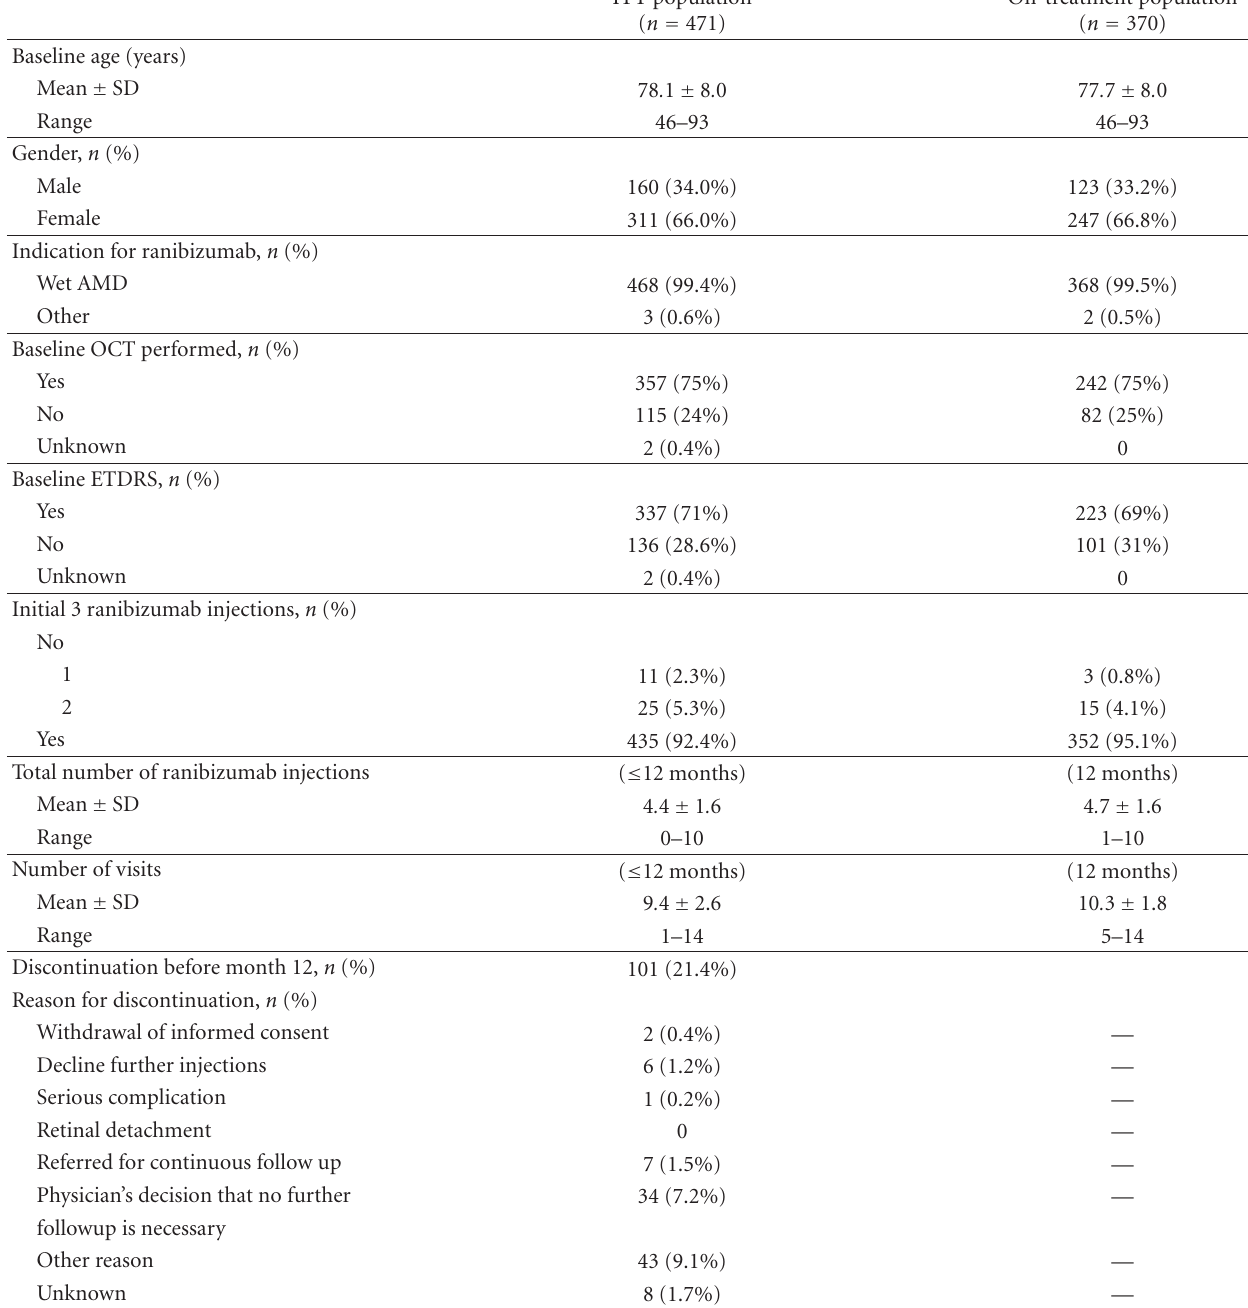
Table 1: Baseline characteristics and ranibizumab